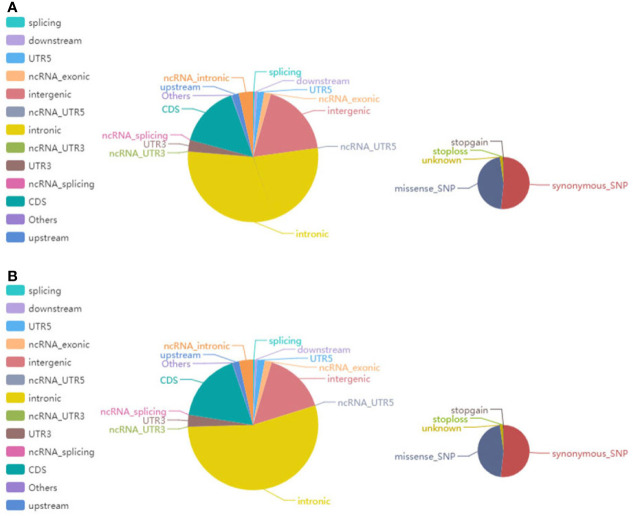
The pie chart shows the distribution of the number of SNPs. (A) The left and right images show the number of SNPs in different regions of the genome and the coding regions in tumor tissue, respectively. (B) The left and right images reciprocally report the number of SNPs in different regions of the genome and the coding regions in normal tissue.